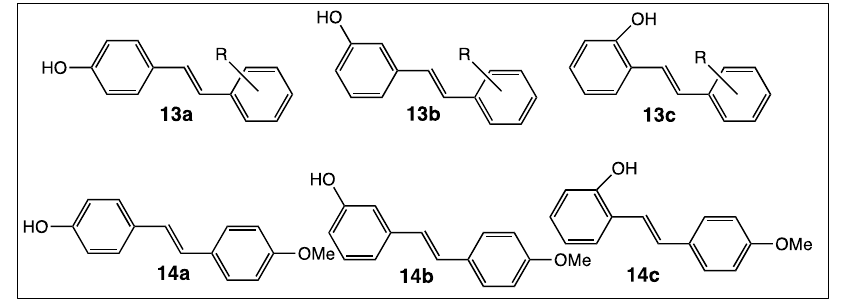
Figure 7 . Structure of 4-hydroxy, 3-hydroxy, and 2-hydroxystilbenes 13a – c and 14a – c.